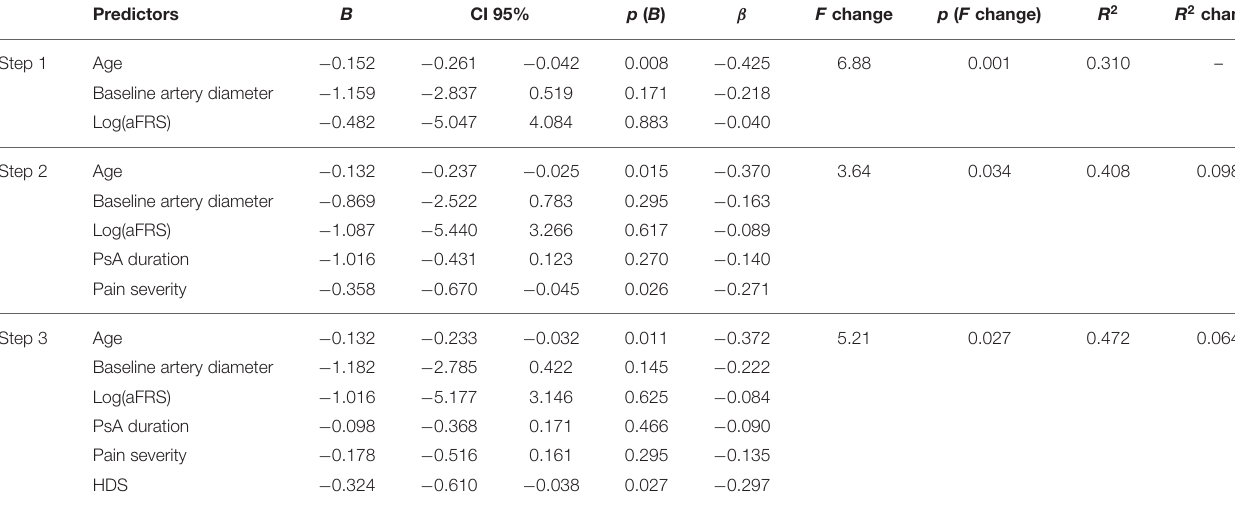
TABLE 3 | Hierarchical linear regression analysis of FMD in patients with